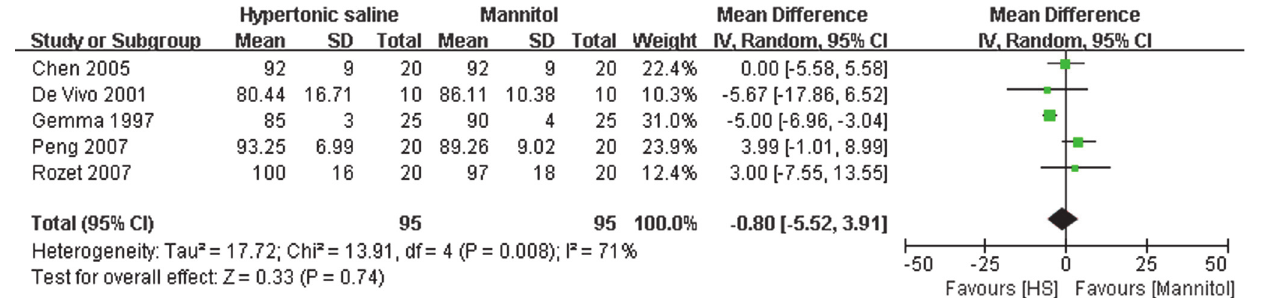
Fig 6. Maximal mean atrial pressure (MAP) in HS and mannitol groups. IV: Inverse Variance.